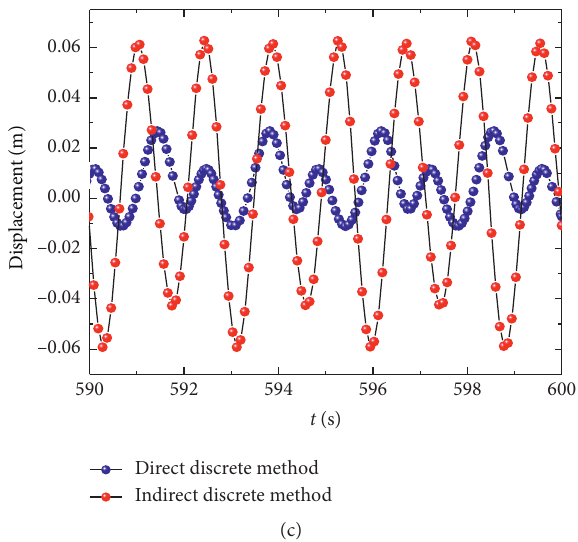
Figure 10: Local displacement. (a) Vertical displacement, (b) Transverse displacement, (c) Torsional